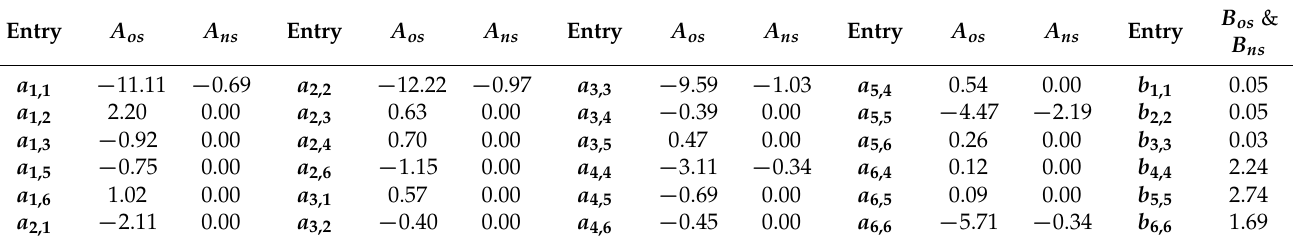
Table 7. Entries for state matrix ( A os and A ns and input matrix ( B os and B ns